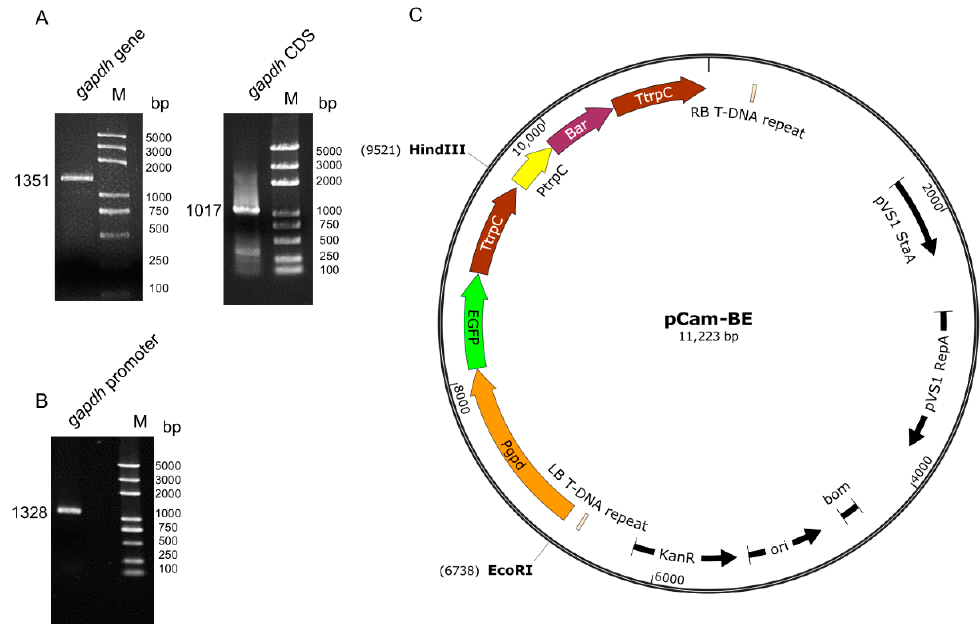
Figure 1. Promoter cloning and vector construction. ( A ) Cloning results of C. farinosa glyceraldehyde 3-phosphate dehydrogenase ( gapdh ) gene, using genomic DNA (gDNA) and complementary DNA